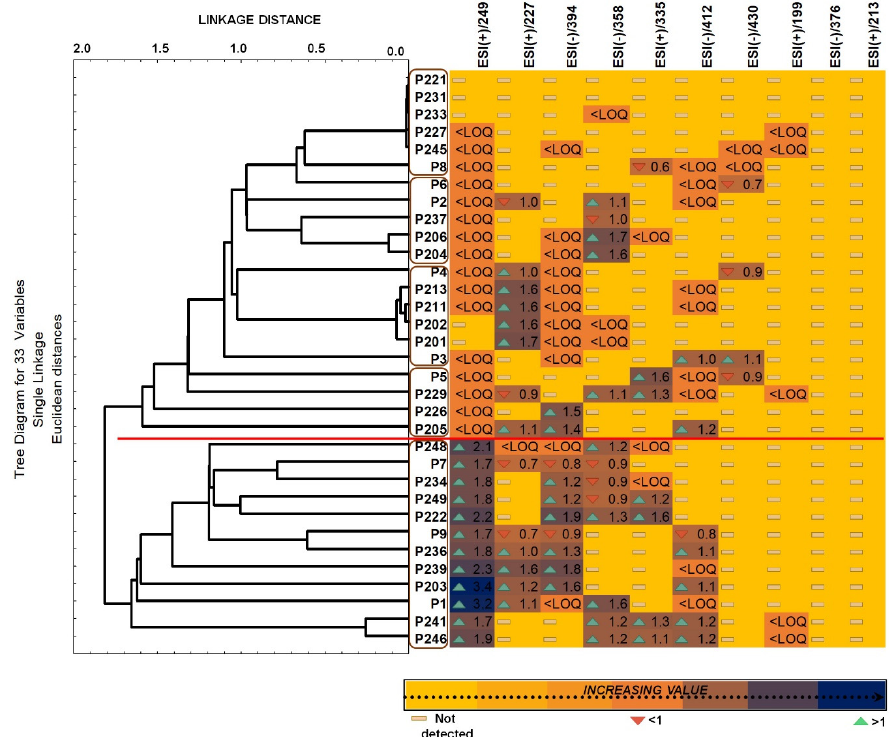
Figure 6. Heat map representing the quantity of investigated compounds detected in patient samples together with clustering analysis showing the correlation between patient samples; where p represents the number of the patient. <LOQ – below limit of quantification (in these cases bisphenols have been identified (but not quantified).